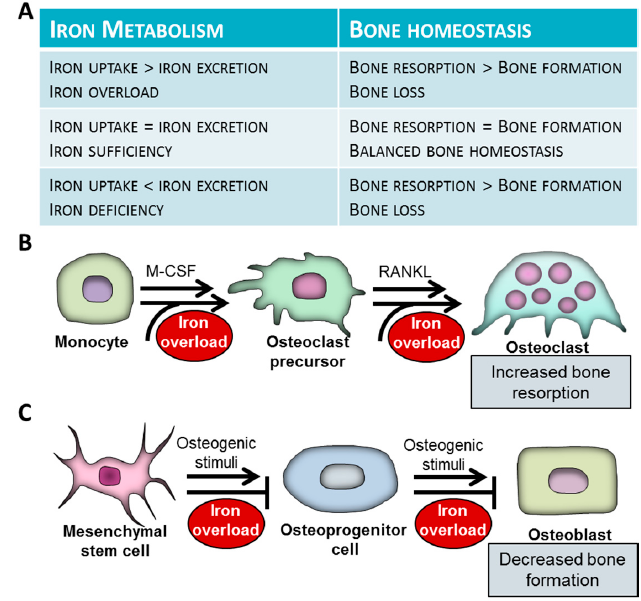
Figure 1. Associations of iron metabolism and bone homeostasis. ( A ) Association between iron metabolism and bone homeostasis. ( B ) The effect of iron overload on differentiation and function of osteoclasts. Osteoclasts derive from myeloid cells of the monocyte/macrophage lineage. Osteoclastogenesis is initiated by macrophage colony-stimulating factor (M-CSF). Bone-resorbing multinuclear osteoclasts are formed from mononuclear osteoclast precursors via fusion. The process is initiated by receptor activator of nuclear factor κ B ligand (RANKL). Iron excess triggers osteoclast differentiation and activation and subsequent bone destruction. ( C ) Osteoblasts differentiate from multipotent mesenchymal stem cells (MSCs). Iron attenuates osteogenic differentiation of MSCs and function of mature osteoblasts. Weak bone phenotype observed in patients with systemic iron overload is a consequence of increased bone resorption by osteoclasts and decreased bone formation by osteoblasts.